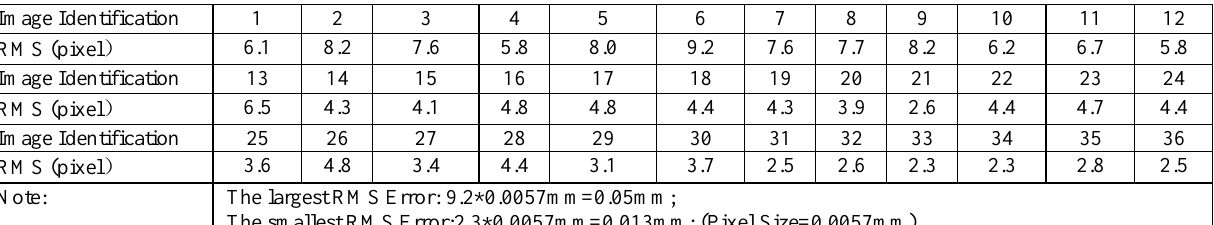
Table 1. RMS errors of the hill area test for 36 UAV